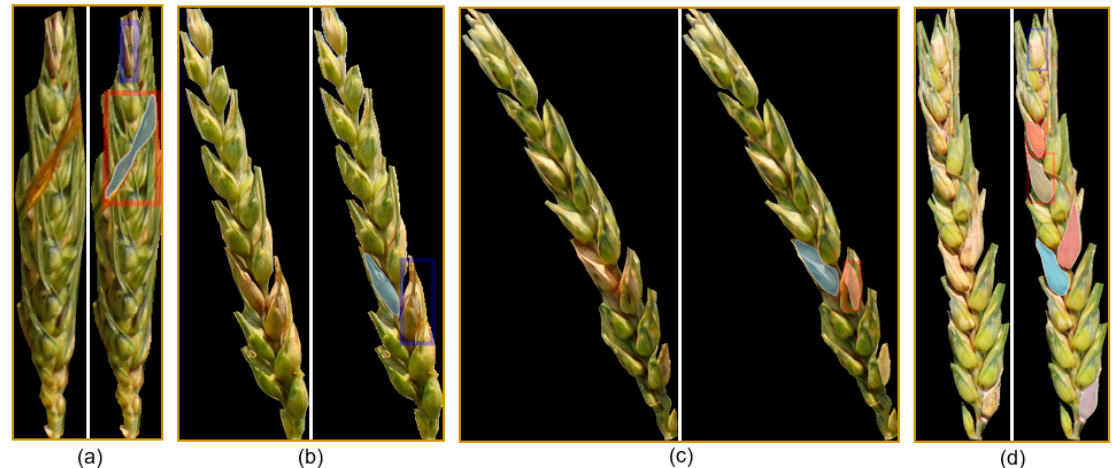
Figure 11. The detection of diseased areas in selected wheat sub-images in the validation dataset; ( a , b ) examples of detection failures caused by model errors; ( c ) an example of detection failures caused by human error due to mis-annotation; ( d ) an example of detection failures caused by model error or human error (the spike with the blue box rectangle was only captured in the ground truth set with no prediction results, while the spike with the red rectangle was only captured in the prediction results not in the ground truth results).